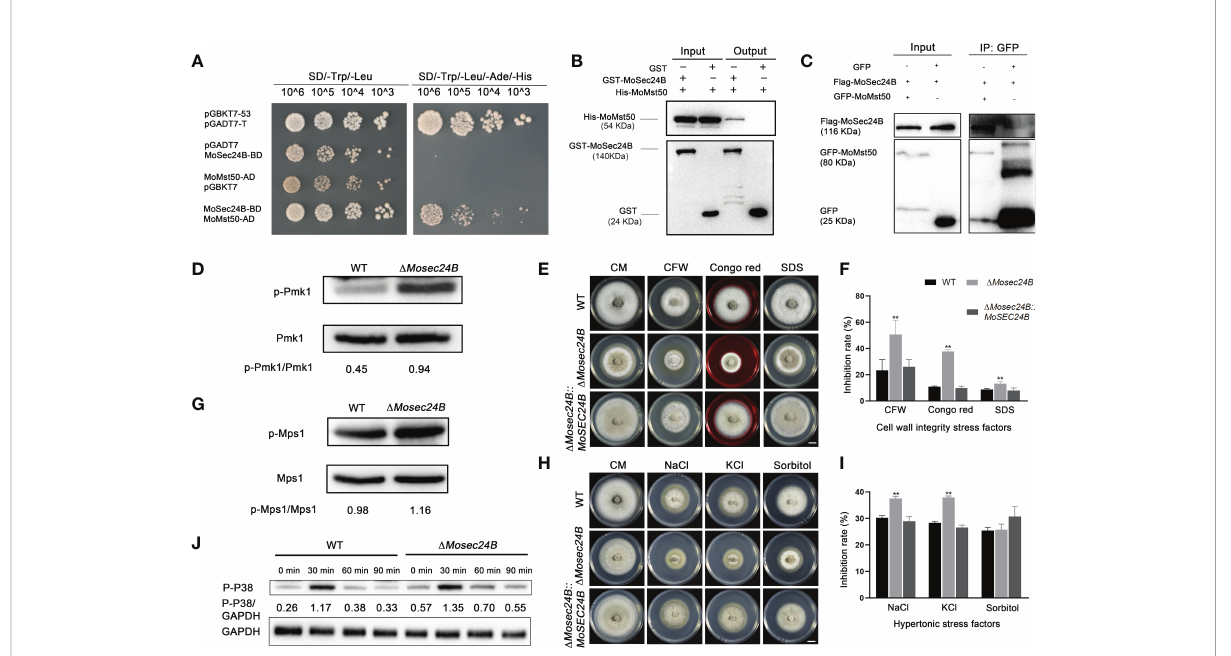
FIGURE 8 (A) Interaction between MoSec24B and MoMst50 was detected using a yeast-two-hybrid assay. (B) Interaction between MoSec24B and MoMst50 was examined using a pull-down assay. (C) Interaction between MoSec24B and MoMst50 was detected using a co-IP assay. (D) Phosphorylation analysis of Pmk1 in WT and D Mosec24B . (E) Mycelial plugs from WT, D Mosec24B , and D Mosec24B::MoSEC24B strains were grown on CM medium supplemented with 100 m g/ml CFW, 800 m g/ml CR, and 0.004% SDS for 8 days. Scale Bar = 1 cm. (F) The growth inhibition rates of WT, D Mosec24B ,